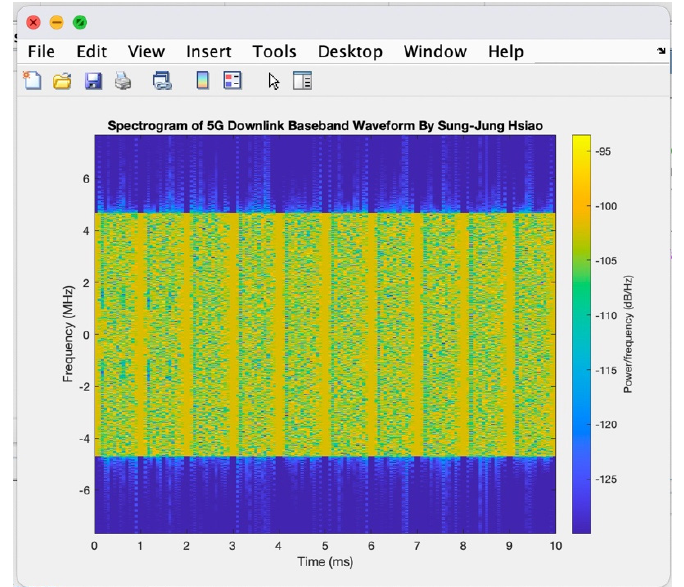
Figure A5. Fifth generation (5G) down-link baseband waveform spectrum.